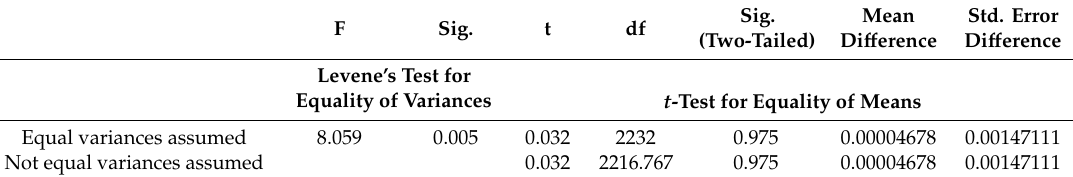
Table 3. Independent samples test.